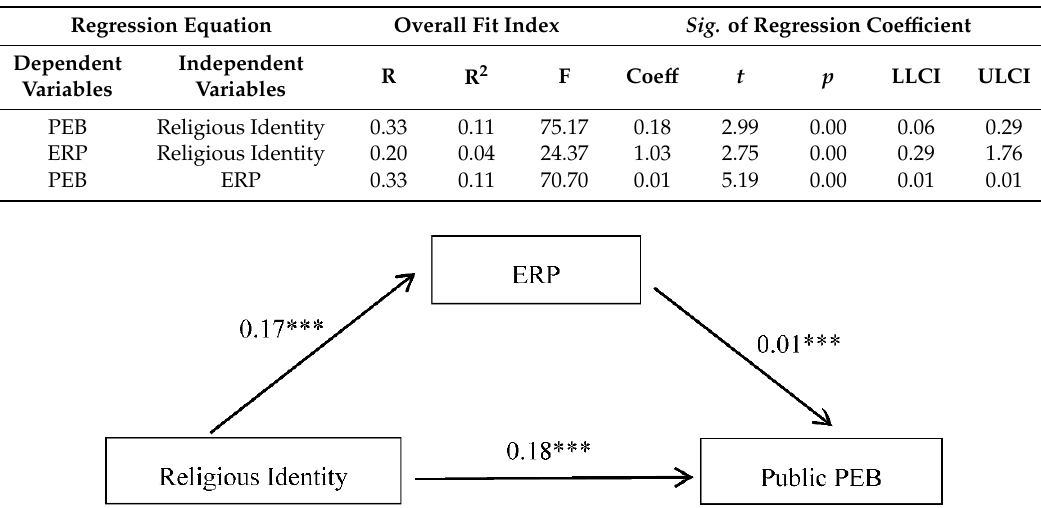
Figure 1. Mediation model of environmental risk perception. t statistics in parentheses; *** p < 0.01 (two-tailed tests).